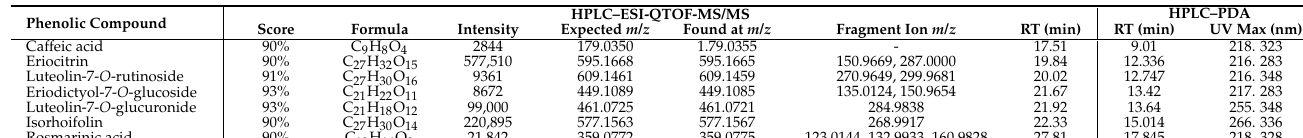
Table 2. Phenolic compounds identified in the European peppermint leaf sample L2 by HPLC–ESI- QTOF-MS/MS and HPLC–PDA.